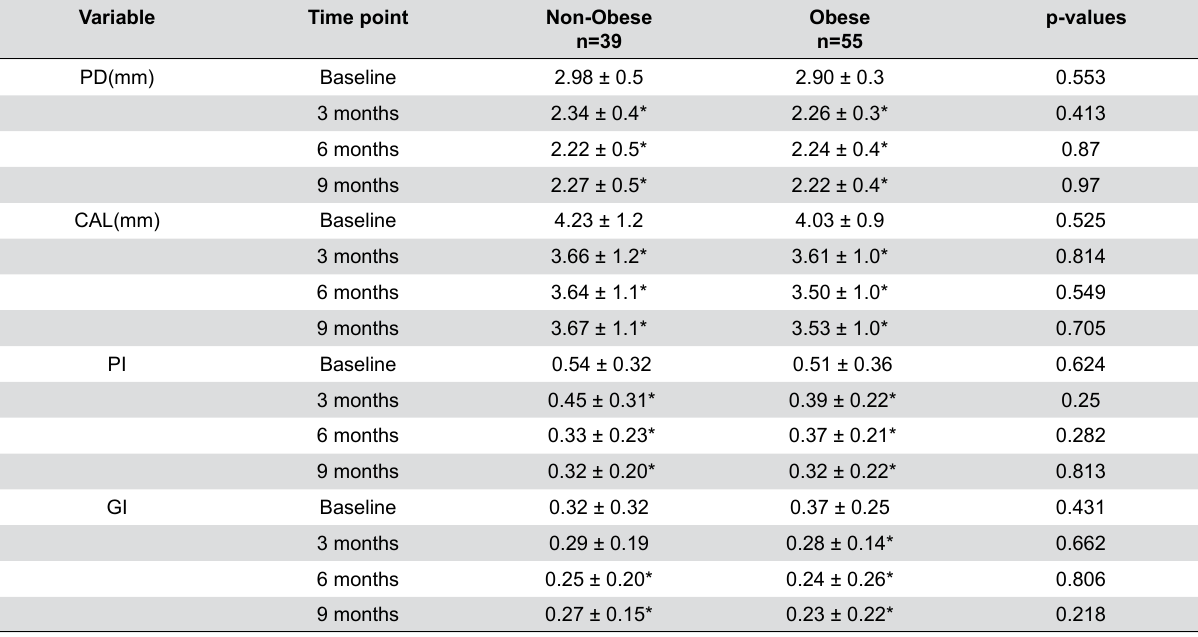
Table 2- Means (±SD) of full-mouth clinical parameters for both groups at baseline and follow-up visits